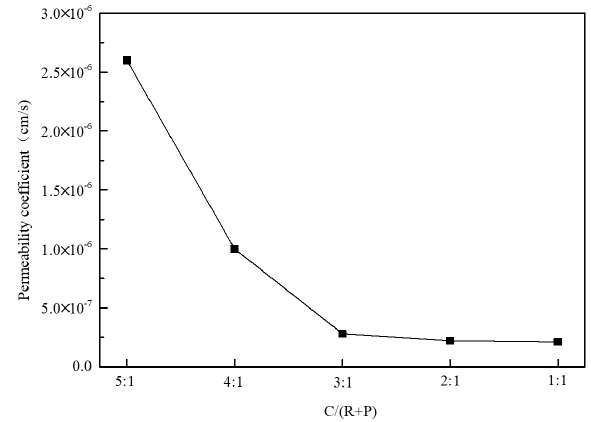
Figure 10. Permeability coefficients of RPCG.